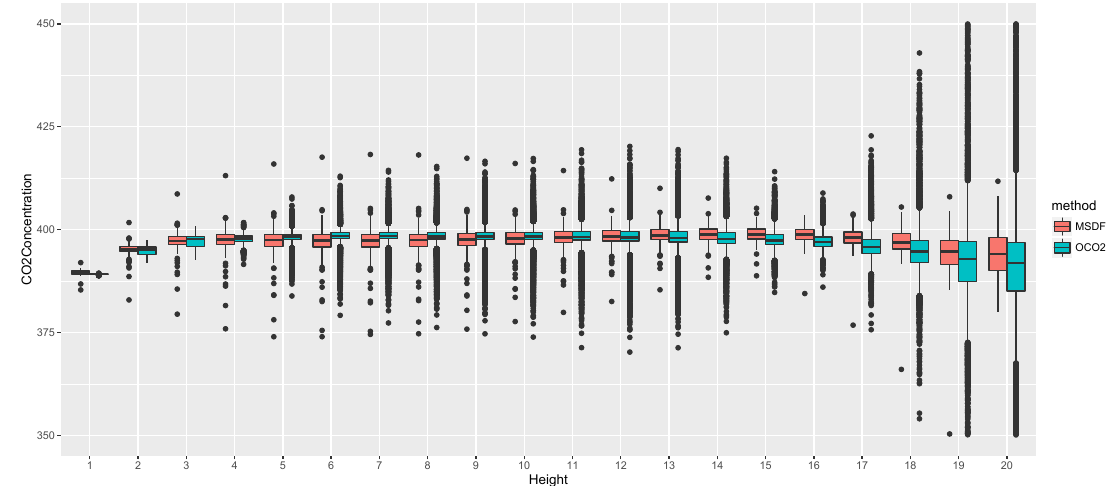
Figure 4. Boxplots of CO 2 concentrations for MSDF predictions and colocated OCO-2 retrieved profiles at Darwin. Heights on the horizontal axis are the index k from height h k ; k = 1, . . .